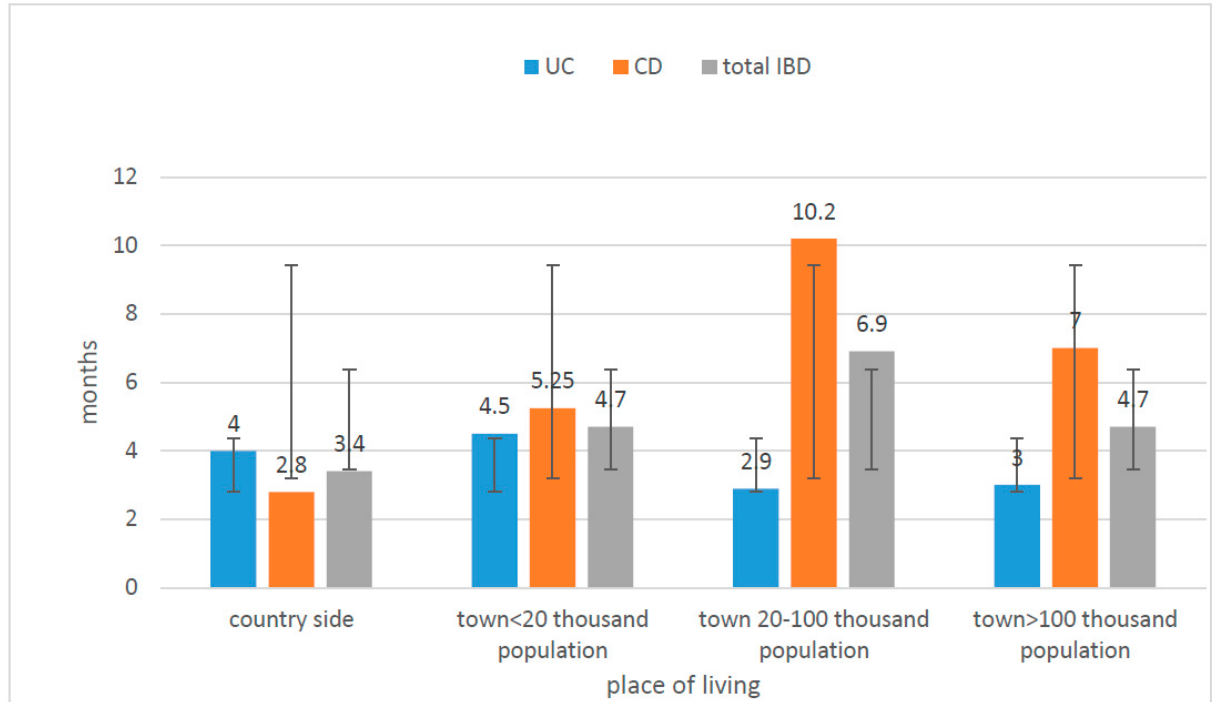
Figure 6. Correlation between time to diagnosis and place of residence: UC—ulcerative colitis; CD—Crohn’s disease; IBD—inflammatory bowel disease.